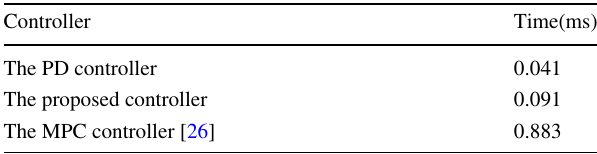
Table 4 The average calculation time of each controller in single step t ) 0.723sin ( t ) (measurement noise 𝜻 ( and measurement delay